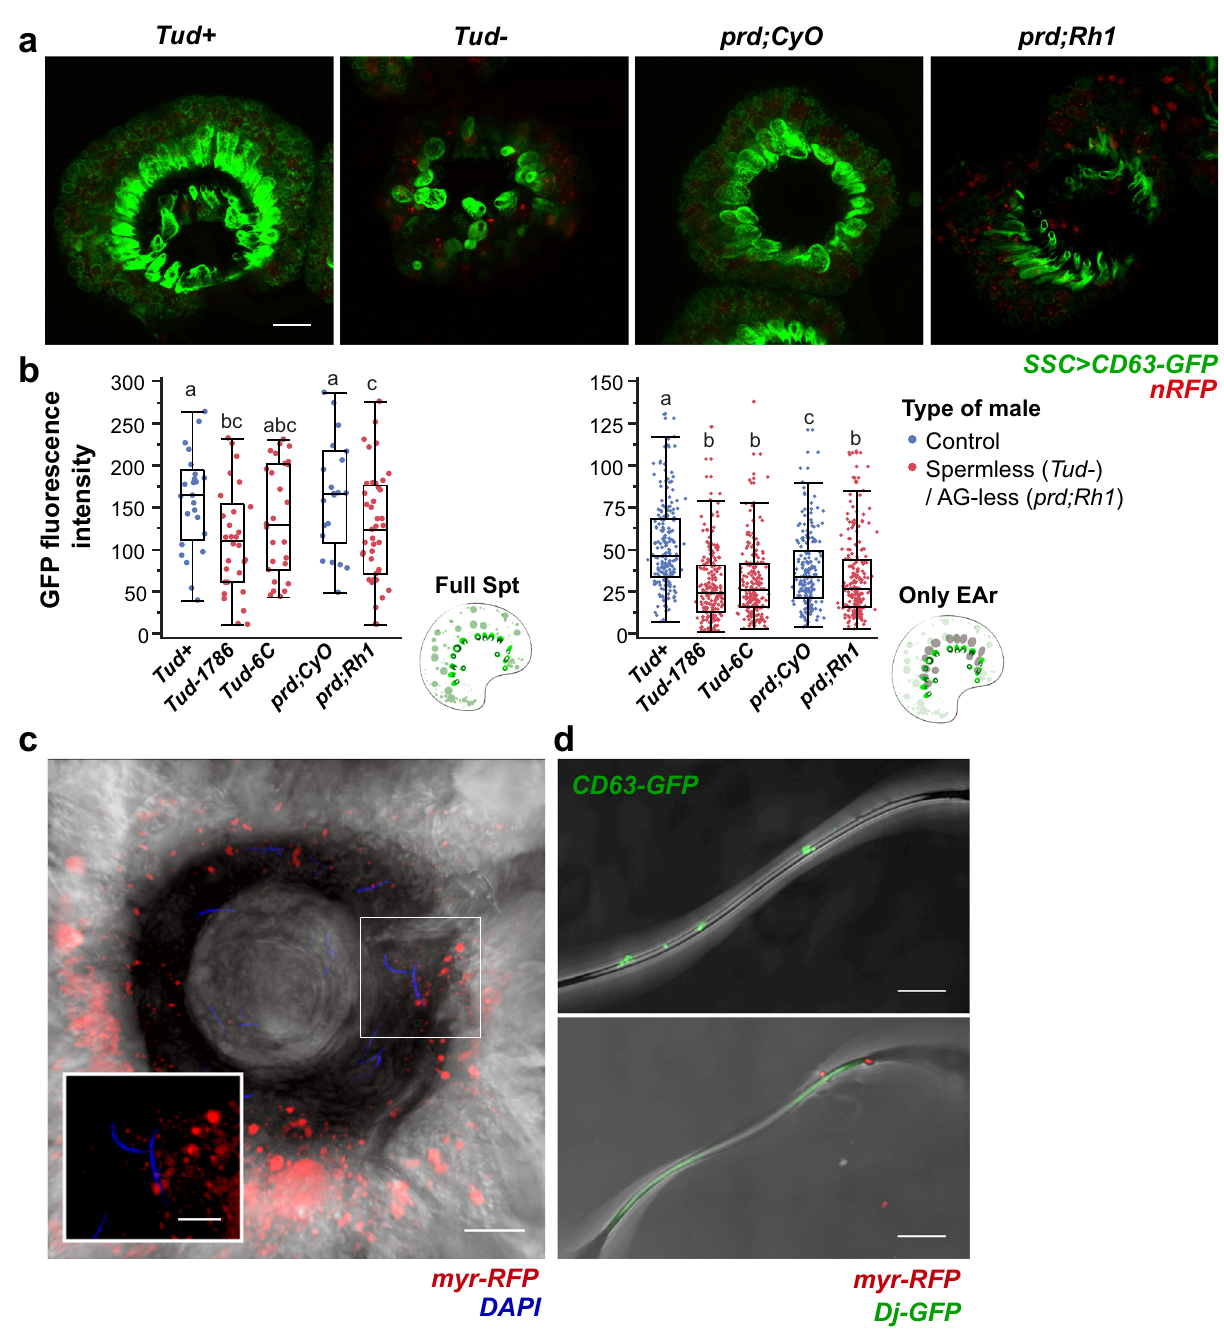
Fig. 8 SSC secretory activity requires both sperm and male accessory gland proteins. a Representative confocal maximum projection images of spermathecae at 24 h post-mating expressing CD63-GFP in the SSC of females mated to the following males: control tudor ( Tud + ), sons of tudor ( Tud - ), control prd ( prd;CyO ), and prd ( prd;Rh1 ). b Mean CD63-GFP fl uorescence intensity of the whole spermatheca, and individual end apparatus reservoir (EAr). The box plot represent maximum, median and minimum values with outliers of 20 spermathecae per condition (From 11 – 15 fl ies); letters denote signi fi cant differences among treatments and were estimated by two-way ANOVA, Tukey HSD, multiple comparison post-hoc test, p < 0.05. c Micrograph of spermatheca with SSC expressing myr-RFP overlaid on the bright fi eld channel depicting DAPI nuclei of sperm in contact with myr-RFP vesicle-like particles in the spermatheca lumen (Supplementary Movie 6 for a 3D overview of c showing sperm surrounded by myr-RFP vesicle-like particles). d Lightning confocal micrographs of sperm isolated from spermathecae expressing CD63-GFP or myr-RFP in the SSC. Scale bar of a , c and d = 20 µ m; inset of c = 5 µ